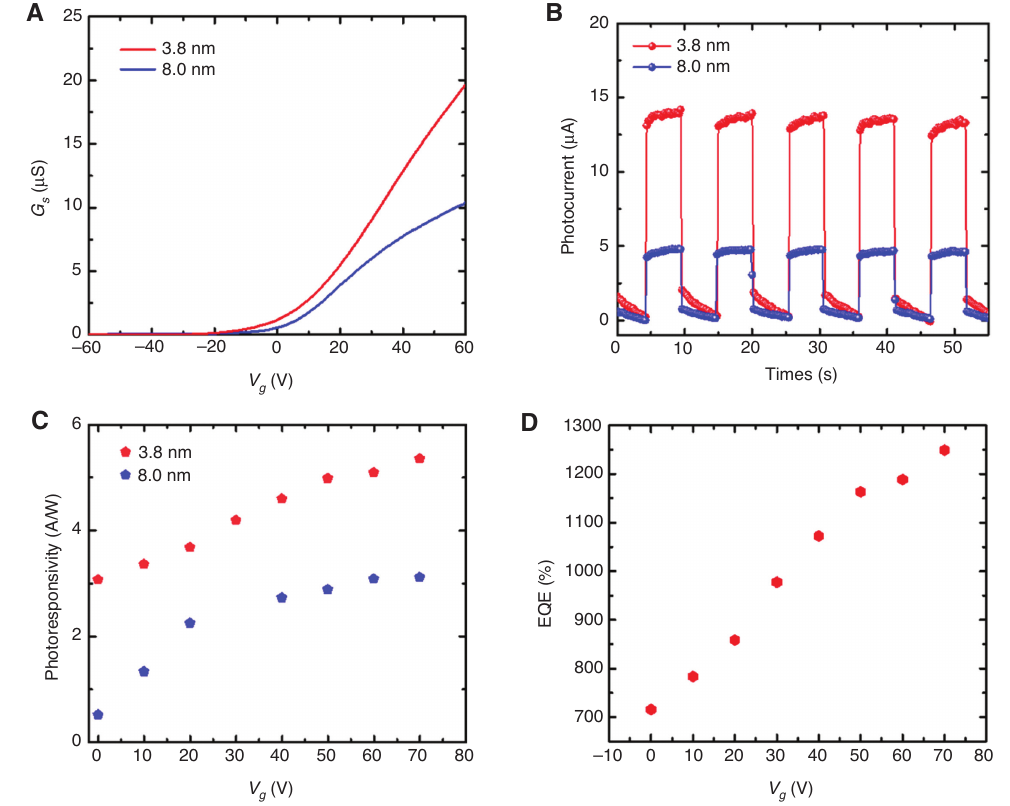
phototransistor. Figure 3: Layer-dependent optoelectronic properties in PdSe 2 (A) Sheet conductance as function of back gate voltages for PdSe phototransistors with different thickness. (B) Time dependence of 2 = 70 V, V = 3 V for PdSe photocurrent measured at V phototransistors with different thickness. (C) Comparison of photoresponsivity for the g sd 2 measured PdSe phototransistors as function of back gate voltage. (D) Back gate–dependent EQE of 3.8-nm-thick PdSe 2